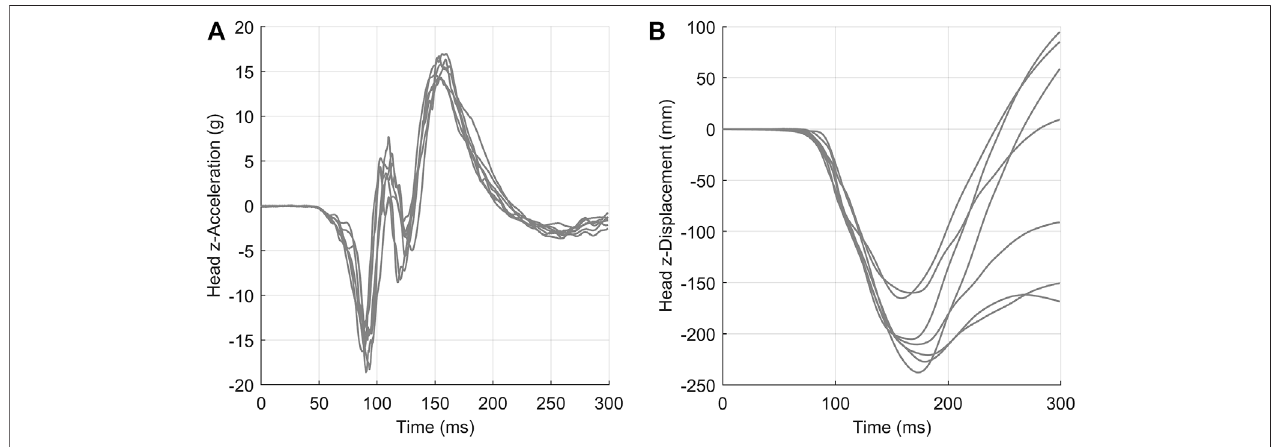
FIGURE 7 | Head acceleration (A) and displacement (B) in the z -direction for a 15 g frontal acceleration. Signals were collected from seven human volunteers.